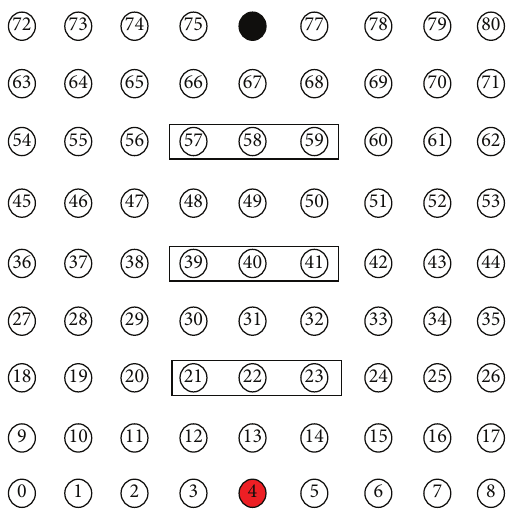
Figure 6: Selected CN groups for data transmission from source node 4 (in red) to sink node 76 (in black).